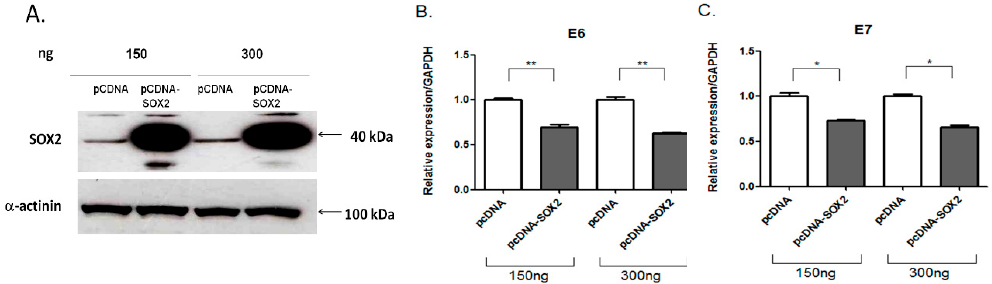
Figure 7. SOX2 represses endogenous E6 and E7 viral oncogenes expression. CaSki cells were transfected with 150 or 300 ng of SOX2 expressing plasmid. ( A ) SOX2 protein levels after transfection are shown. For protein loading control, α -actinin levels were analyzed. Quantitative Reverse transcription-polymerase chain reaction (qRT-PCR) of endogenous E6 ( B ) and E7 ( C ) viral oncogenes in the presence or absence of overexpressed SOX2, was performed. The empty vector pcDNA was used as a control. E6 and E7 expression levels were significantly diminished in the presence of SOX2. Data were normalized to the housekeeping gene GAPDH. Standard error of the mean is shown. * p < 0.05; ** p < 0.01.